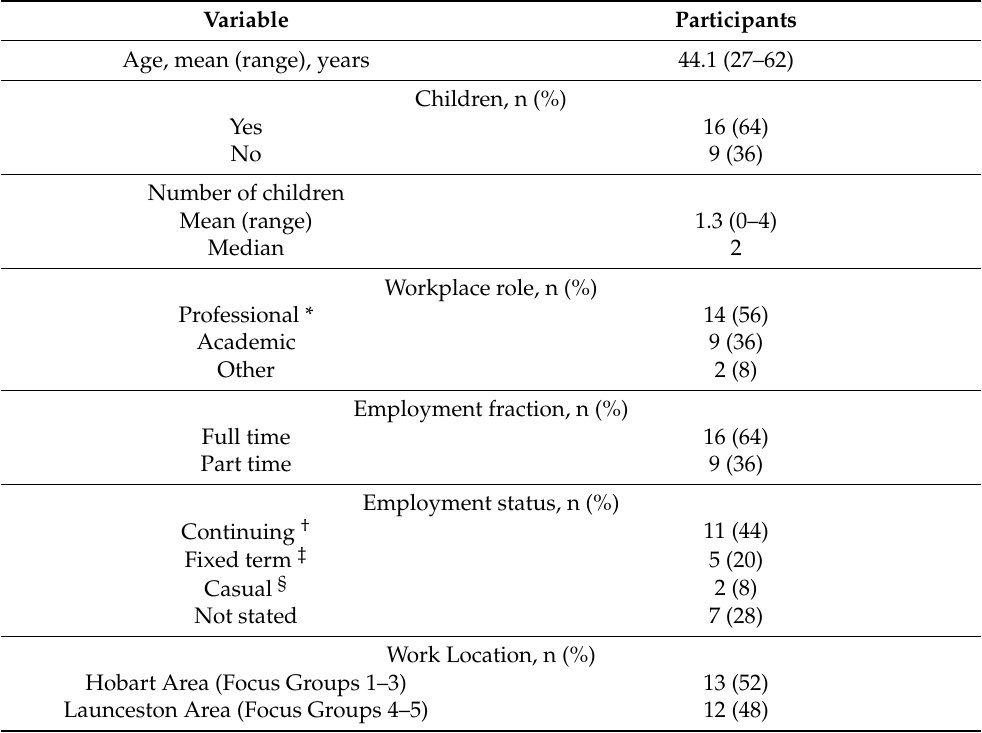
Table 1. Demographic Information of Participants ( N =